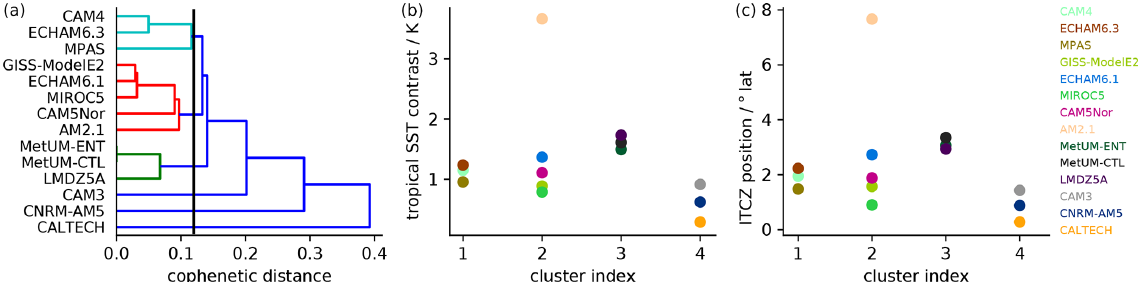
Figure 6. Model clustering based on the AquaControl networks without extratropical–extratropical connections (a) and values of the tropical SST contrast (b) and ITCZ position (c) for all models in the four identified clusters. (a) The dendrogram obtained from the hierarchical clustering of the zonal-mean network measures. The vertical line indicates the level of cophenetic distance at which we split the models into four clusters.